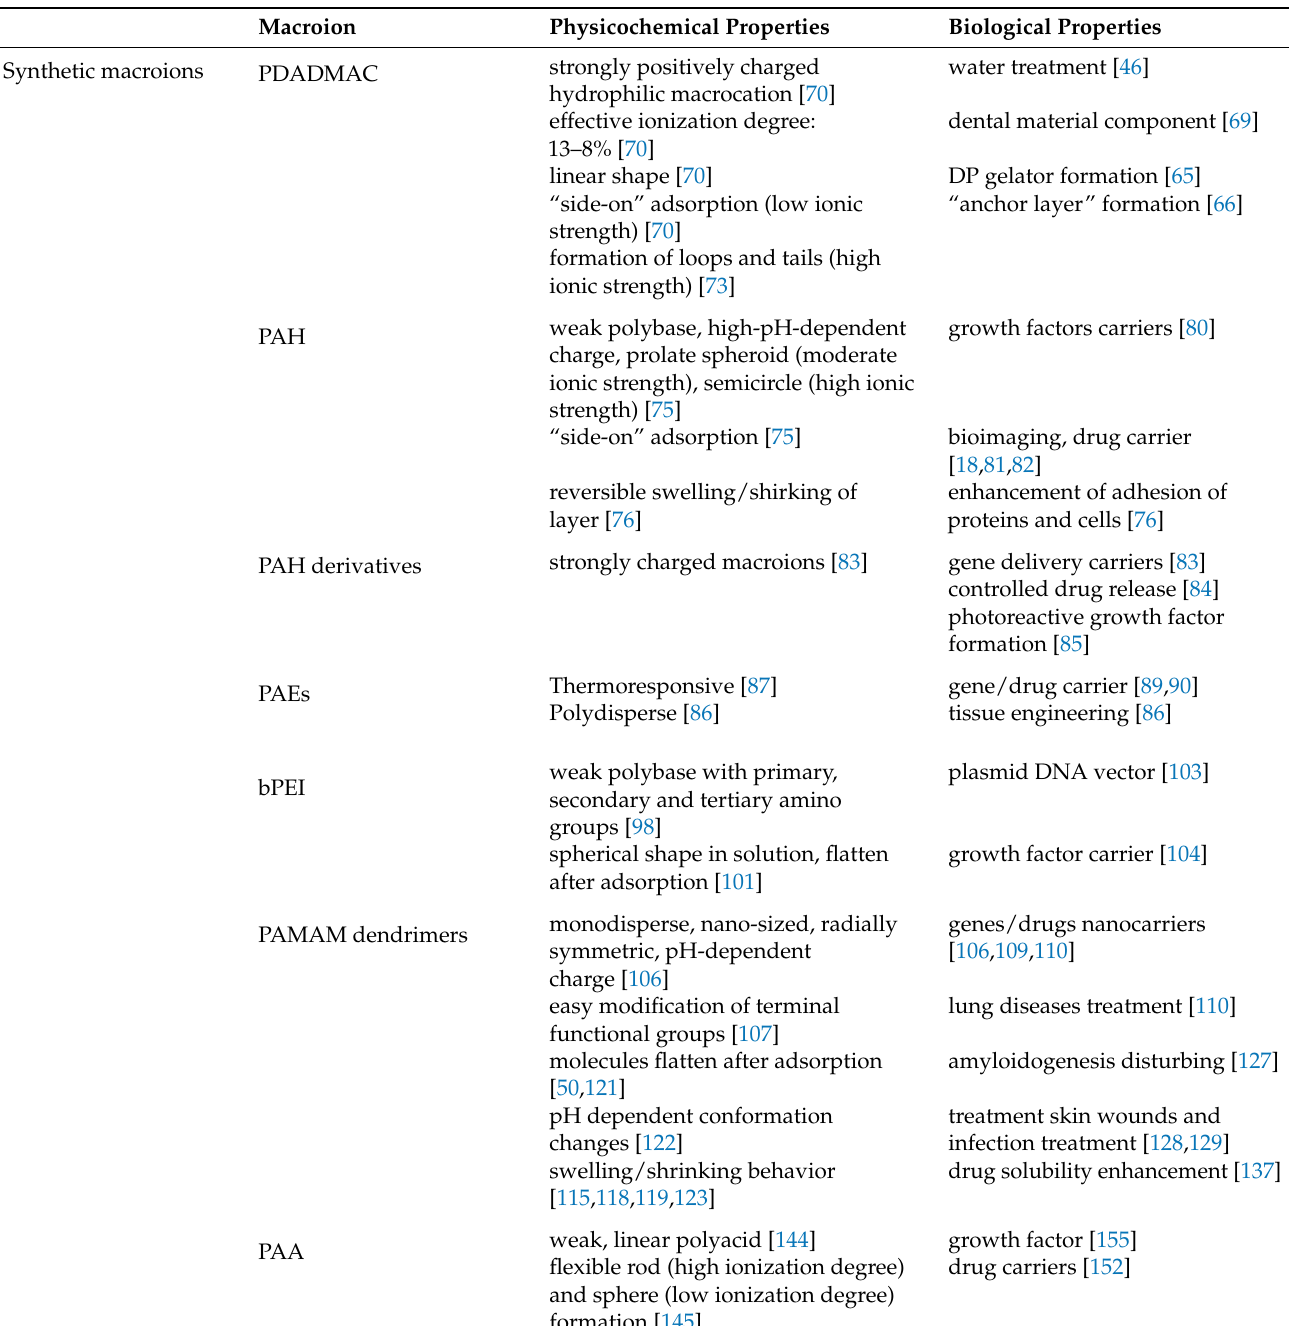
Table 3. Physicochemical and biological properties of the biocompatible